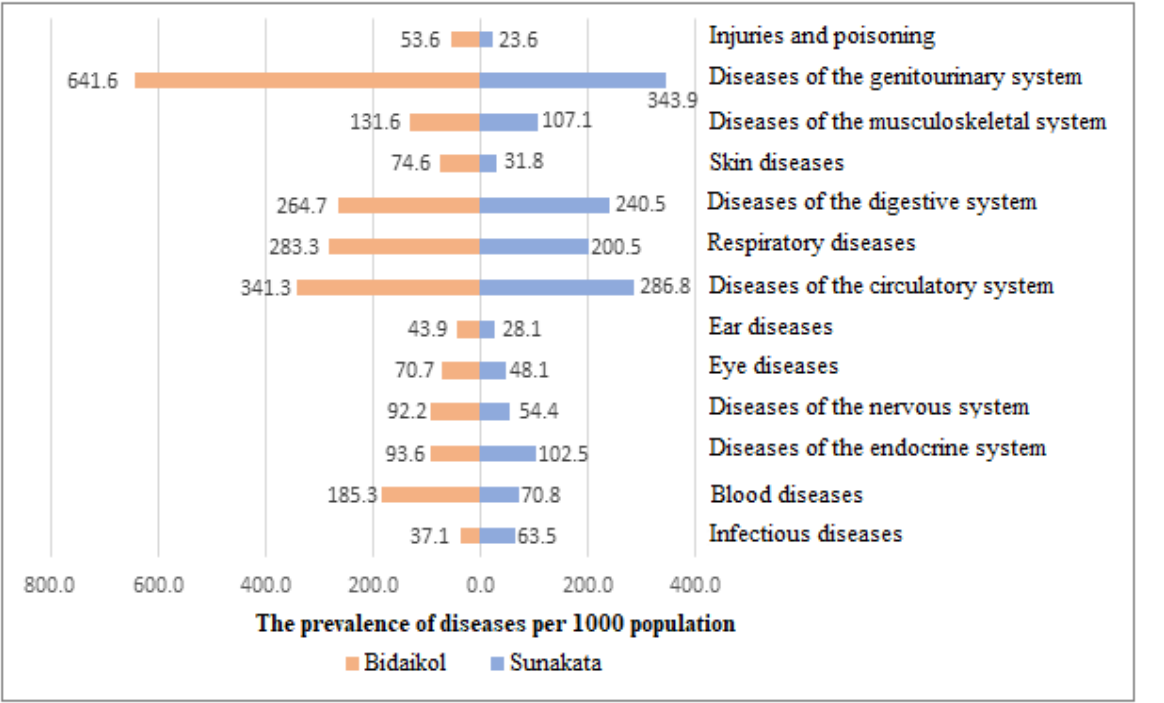
Figure 2. Comparative characteristics of the prevalence of diseases in the studied groups (per 1000 people).